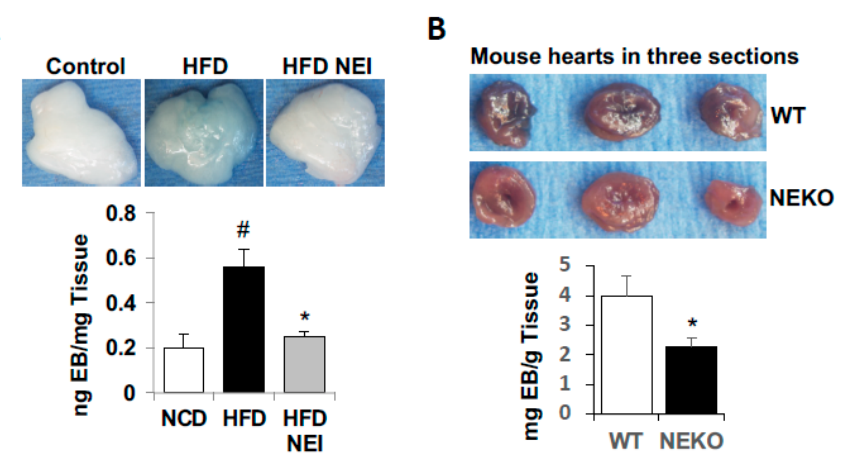
Figure 6. Inhibition of NE attenuated HFD-feeding-induced vascular leakage in WAT and heart. ( A ) C57BL/6J mice (8-week-old males) were fed either a standard chow diet, HFD (60% kcal of fat), or HFD plus NEI (GW311616A, 25 mg/kg HFD) for 5 weeks. ( B ) NEKO and WT controls (7-week-old, females) were fed with 60% HFD for 10 weeks. Then, at the end of feeding study, mice were injected with Evans Blue-albumin (EB, intravenous retro-orbital injection) for 2 h before being perfused with PBS to remove the dye in the blood vessels. Evans Blue leakage into epididymal fat ( A ) and heart ( B ) was quantified as described in the Materials and Methods section. ( A , B ) Top panels show representative WAT and heart images; lower panels show quantification of Evens Blue-albumin dye. ( A ) Data are presented as mean ± SD, n = 4 in each group. # p < 0.05, chow versus HFD; * p < 0.05, HFD vs. HFD plus NEI. ( B ) Data are presented as mean ± SD, n = 5/group, * p < 0.05, NEKO vs. WT.